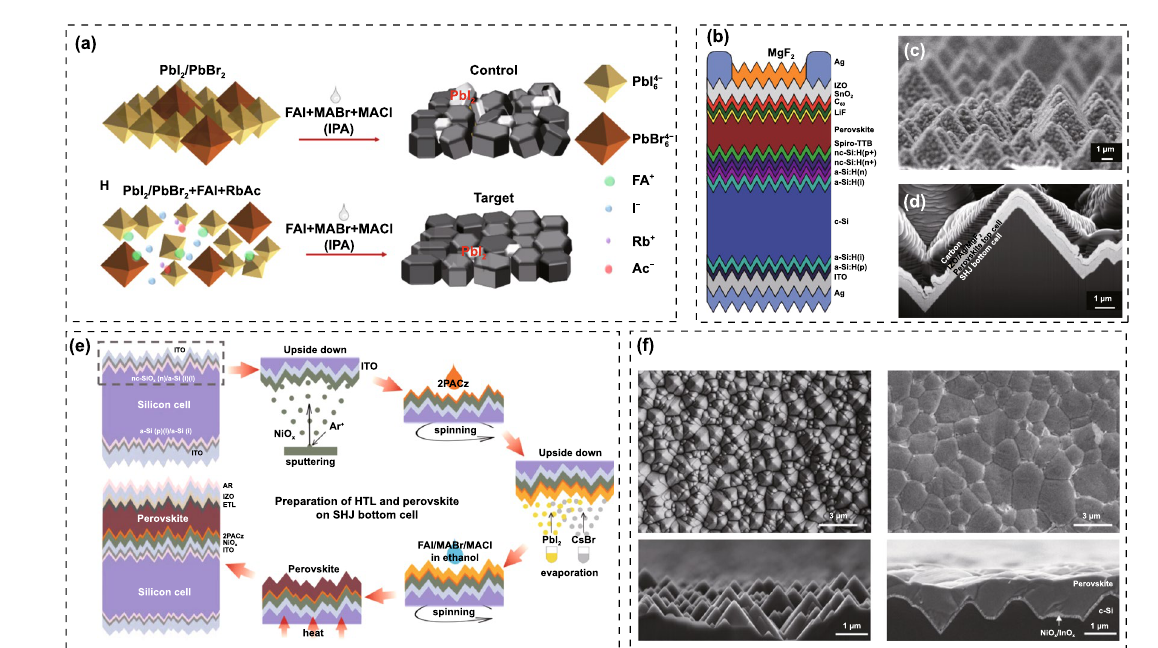
Fig. 15 a Schematic diagram of two-step preparation method. Reproduced with permission from Ref. [238]. Copyright 2022, American Chemi- cal Society. b Schematic view of a fully textured monolithic perovskite/SHJ tandem. c Secondary electron SEM image of the perovskite layer. d Cross section of the full perovskite top cell deposited on the SHJ bottom cell. Reproduced with permission from Ref. [193]. Copyright 2018, Nature Publishing Group. e Schematic illustration of the processing procedures of NiO x /2PACz hybrid HTL and perovskite on fully textured bottom SHJ cell. Reproduced with permission from Ref. [188]. Copyright 2022, Wiley–VCH. f SEM top-view and cross-sectional images of the textured c -Si and c- Si/perovskite layers. Reproduced with permission from Ref. [243]. Copyright 2020, Science Publishing